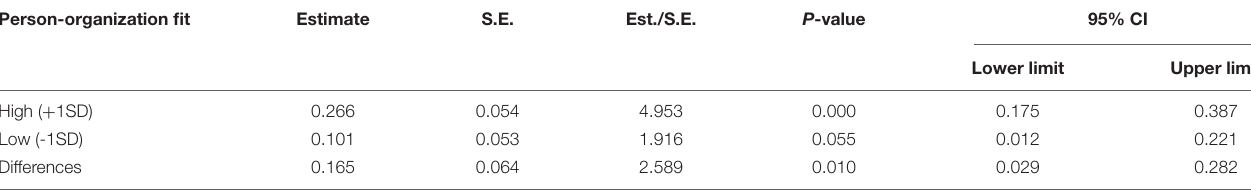
TABLE 4 | Results of moderated mediating effect test (DL → JC →